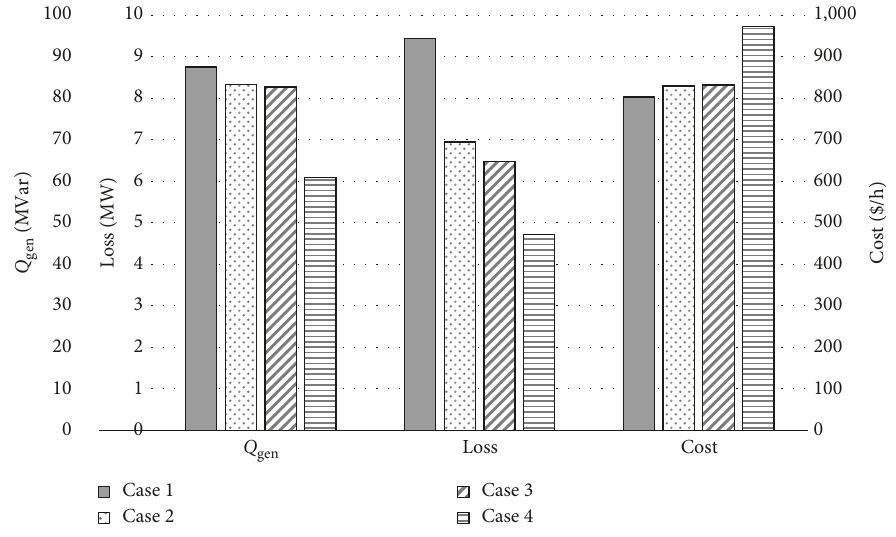
Figure 3: Variable comparisons for the IEEE 30-bus test system. Table 2: System performance of the IEEE 57-bus test